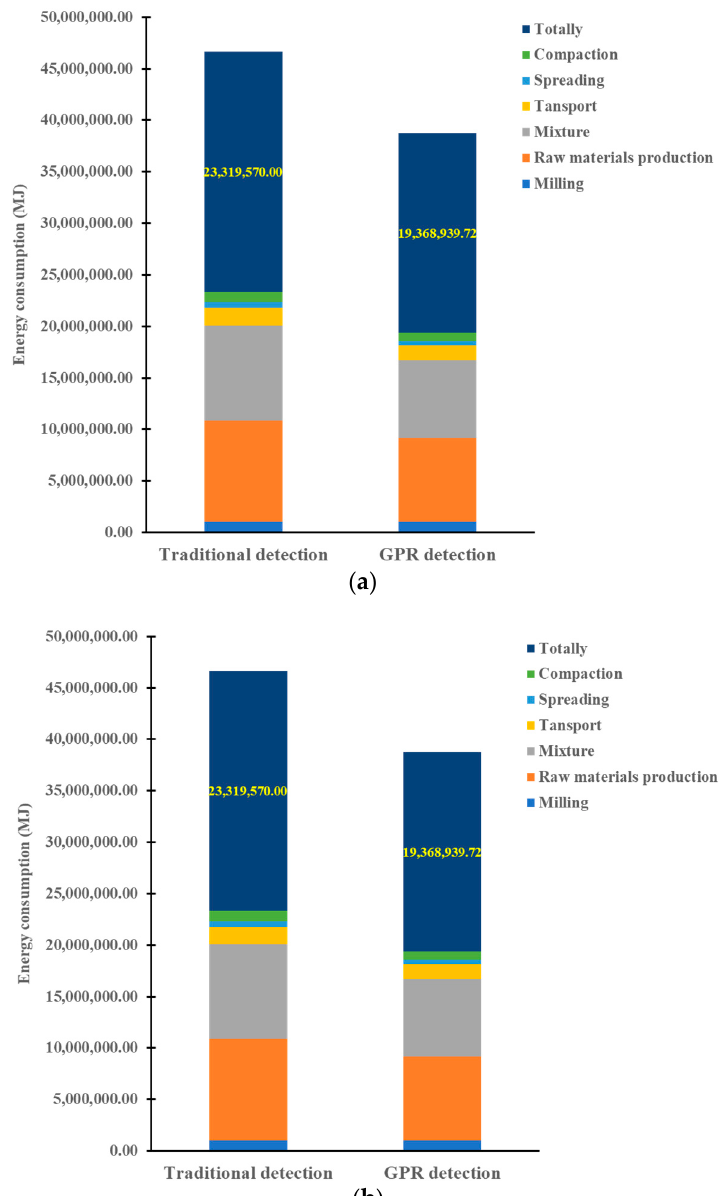
Figure 14. The contrast for energy consumption ( a ) and carbon emissions ( b ) of the two detecting methods.